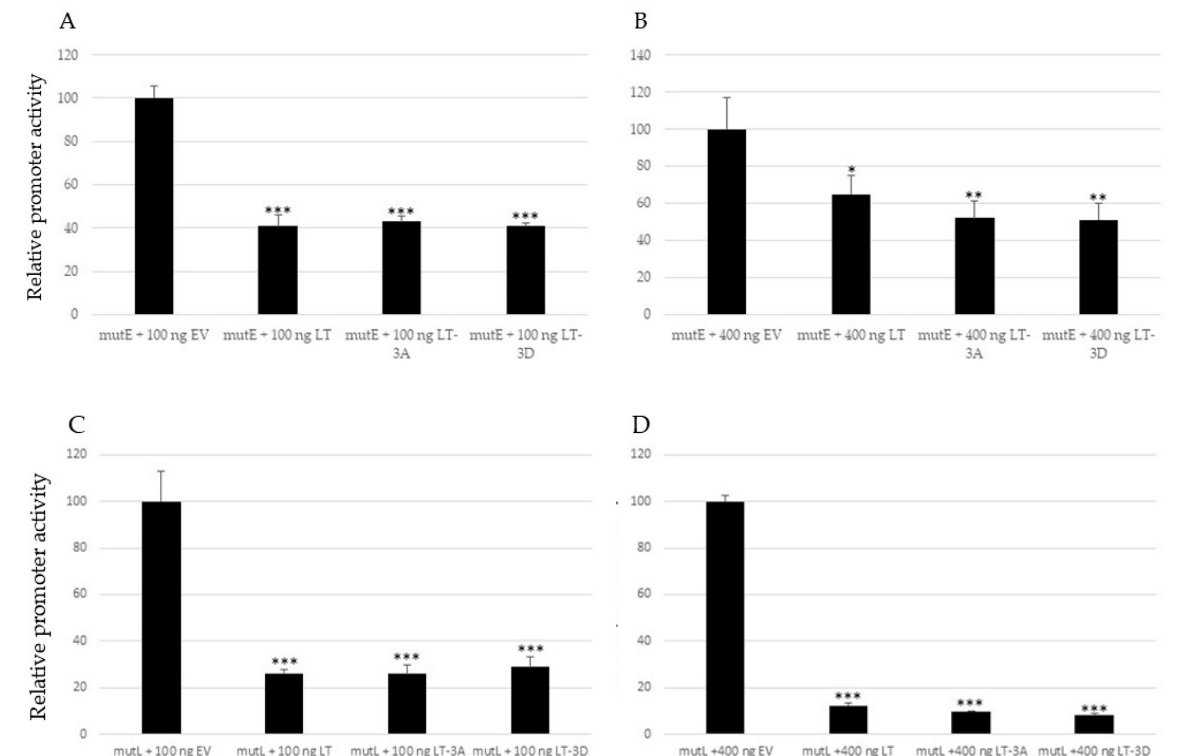
Figure 5. Full-length LTag and triple mutants inhibit MCPyV early and late promoter activity. HaCaT cells were co-transfected with 1 µ g luciferase reporter plasmid containing the replication deficient early ( A , B ), or late promoter ( C , D ) and 100 ng ( A , C ), or 400 ng ( B , D ) empty vector (EV), or expression plasmid for full-length LTag, the tripe mutants 3A (LT-3A) or 3D (LT-3D). Each bar represents the average of three independent parallels with standard deviation. Statistically significant differences with empty expression vector are indicated (* p < 0.05; ** p < 0.01; and *** p < 0.001). Luciferase values were corrected for protein concentration of the sample and the corrected value for the empty vector was arbitrarily set as 100%.